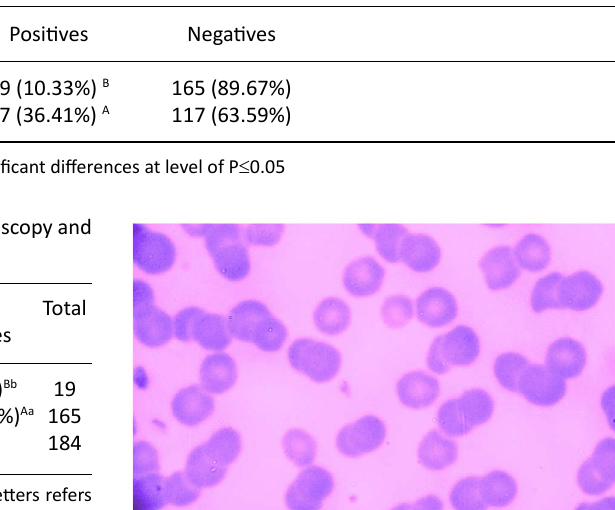
Fig. 1. Intra-erythrocytic A. marginale inclusion bodies The results of (Table 2) showed that